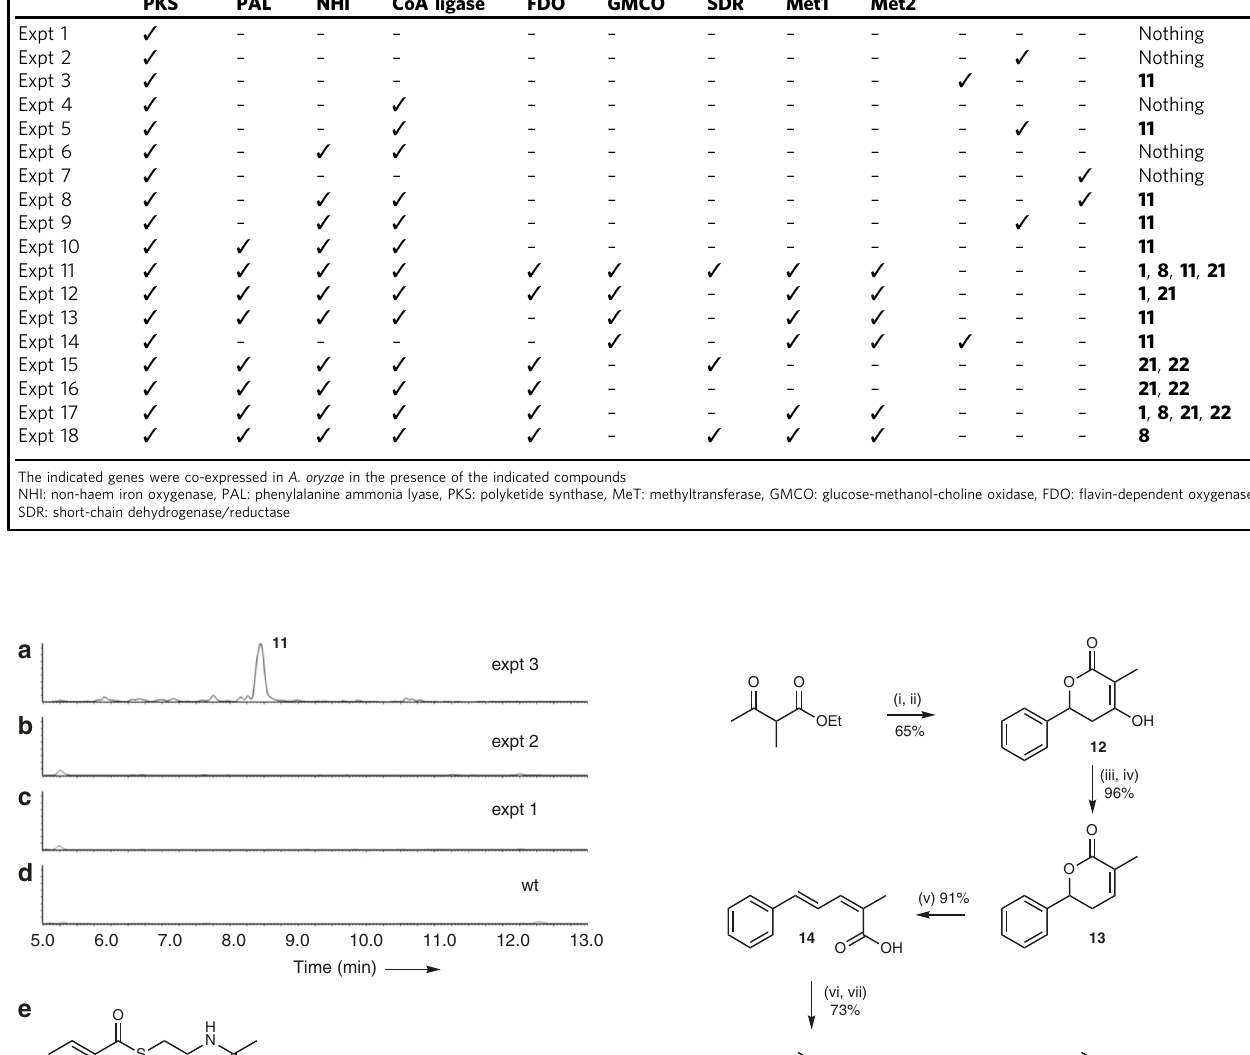
Table 2 Summary of heterologous expression experiments in A. oryzae designed to probe the biosynthesis of 1 Construct